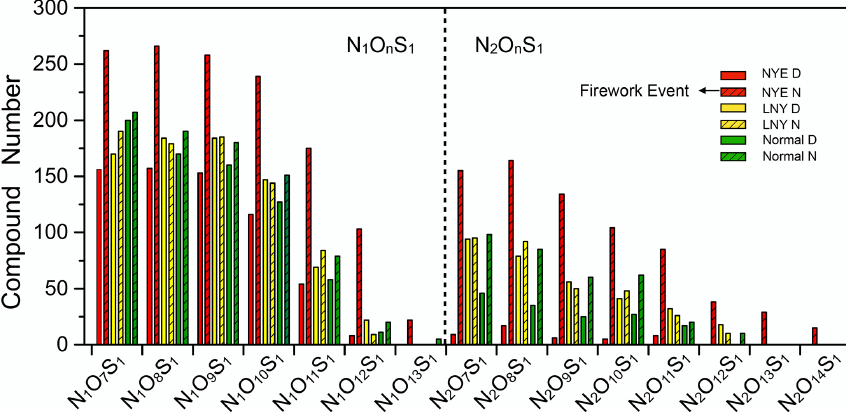
Figure 2. Classification of nitrooxy OSs according to the numbers of N, S, and O atoms in their molecules.